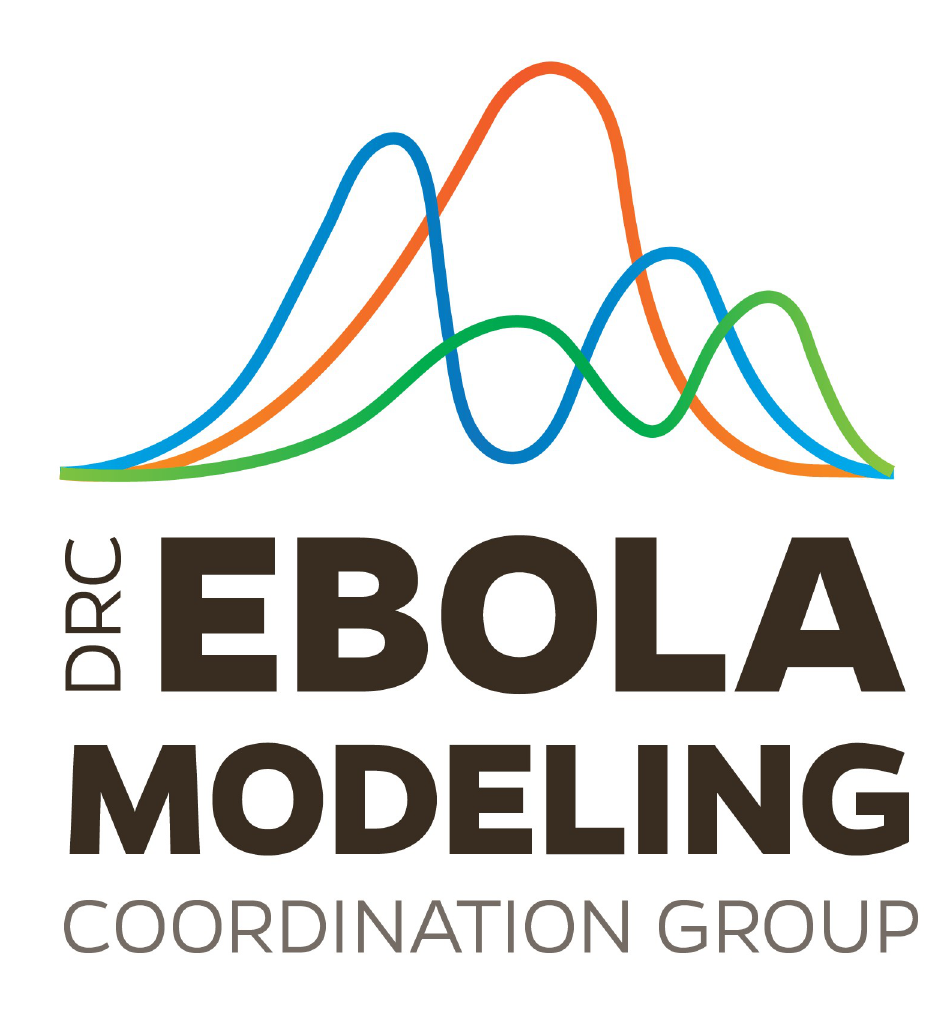
Fig 1. The logo of our informal Ebola modeling coordination group. DRC, Democratic Republic of Congo.